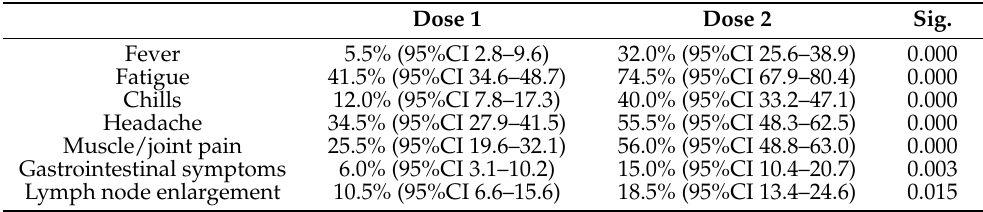
Table 6. Difference in reporting of systemic adverse reactions in the 7 days after the first and second vaccine dose